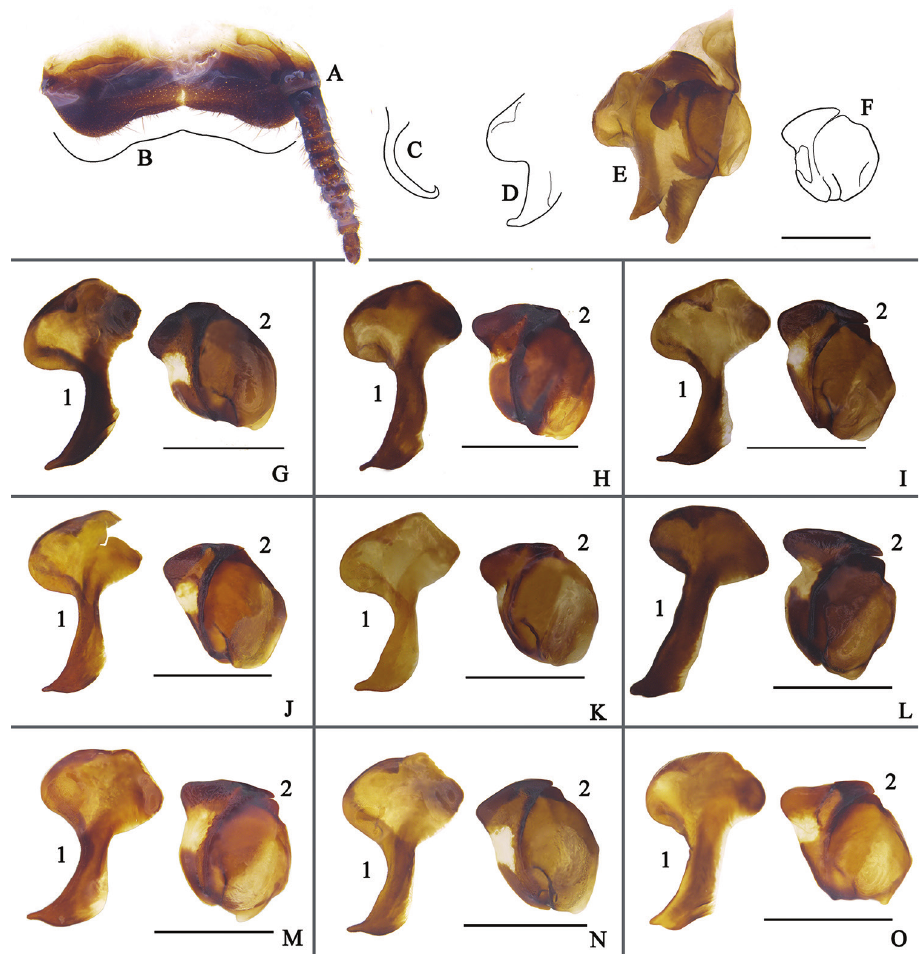
Figure 6. A–O Features of male Eucorydia dasytoides A supra-anal plate, ventral B hind margin of the supra-anal plate C genital hook (L3) D appendage sclerite (L7) E right phallomere with L7 F R2 G–O variation of the appendage sclerite ( 1 ) and R2 ( 2 ) from different localities: G from Jinxiu, Guangxi H from Mt. Jiangfengling, Hainan I from Taoyuan, Taiwan J from Taidong, Taiwan K from Mt. Tian- mushan, Zhejiang L from Mt. Wuyishan, Fujian M from Yueyang, Hunan N from Zhenyuan, Guizhou O from Zhaotong, Yunnan. Scale bars 1